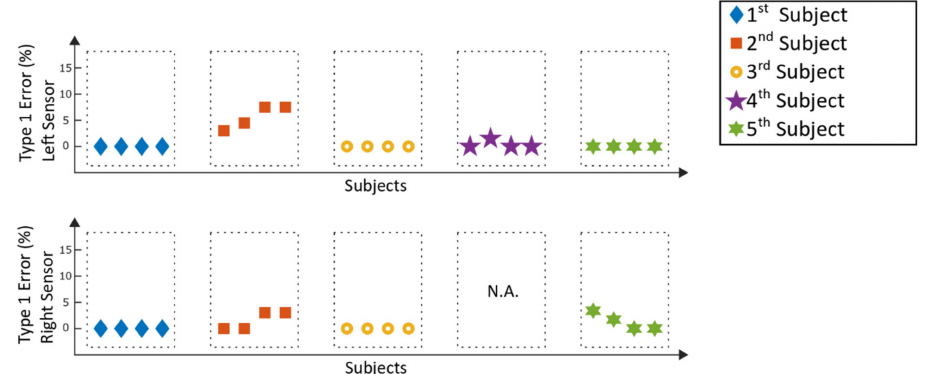
Figure 9. Lyra measurements: detection rates of the selection windows.